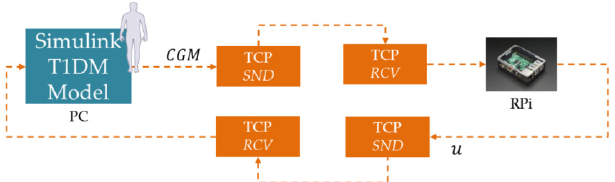
Figure 4. TCP (Transmission Control Protocol) communication protocol for RPi (Raspberry Pi) and PC. RCV and SND indicate receive and send data respectively.